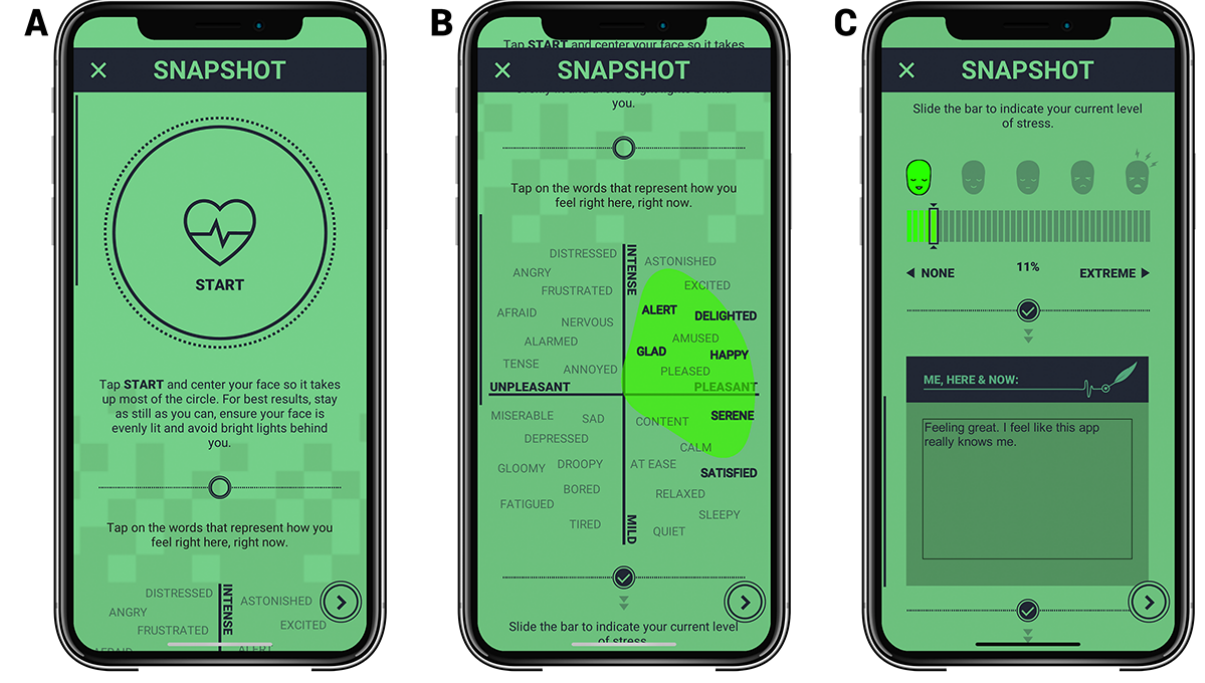
Figure 3. In-App Psychobiometric Assessments within Am . (A) “Selfie” video using photoplethysmography technology to quantify stress; (B) “Mood board” containing 32 emotion words and “stress slider” for stress self-assessment; and (C) “Journaling” feature to input